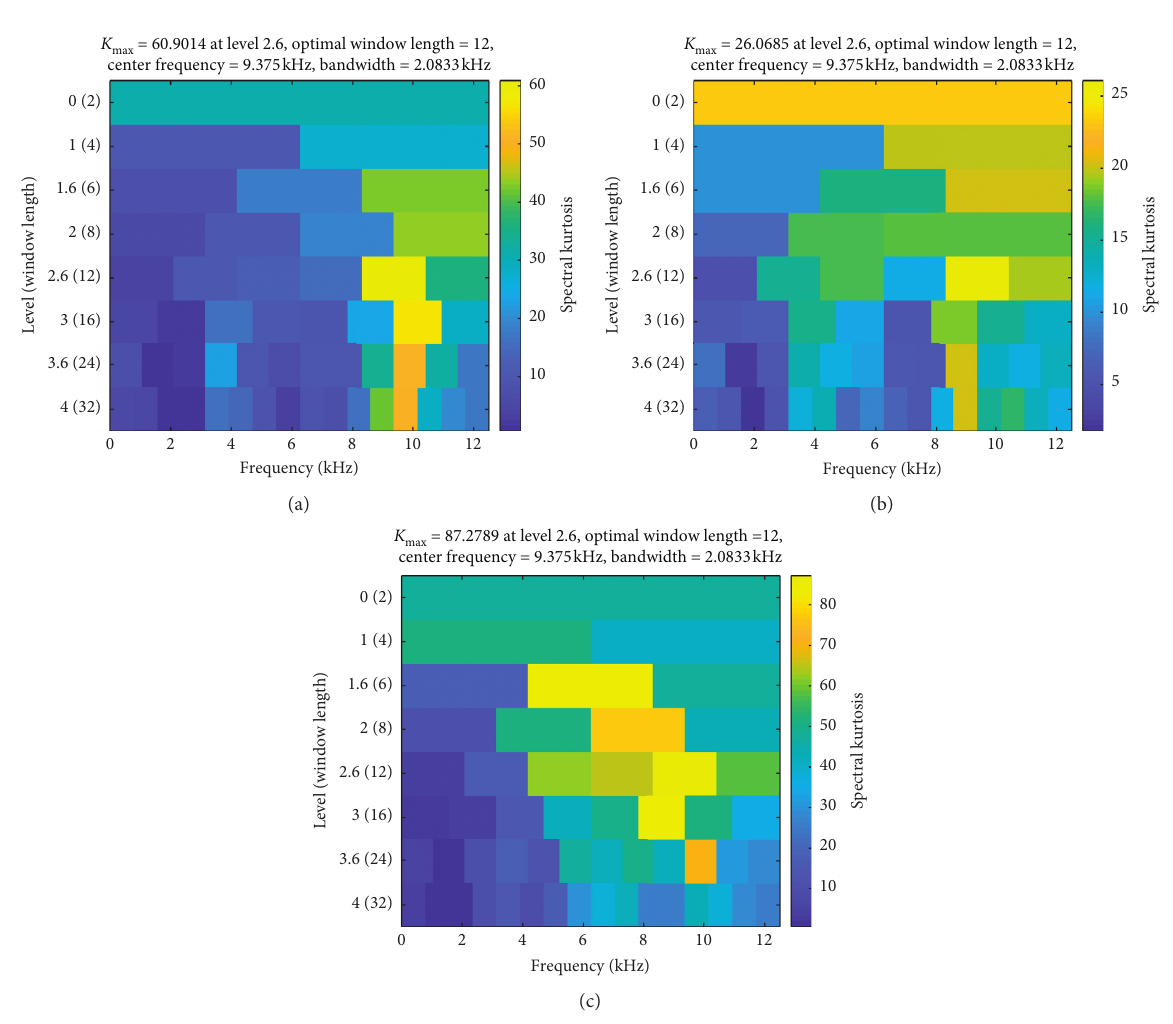
Figure 8: Fast kurtogram of the 3 conditions. (a) Condition 1. (b) Condition 5. (c) Condition 8. Table 2: The RMS value as well as 4 typical kurtosis statistics of signals under 8 working conditions.